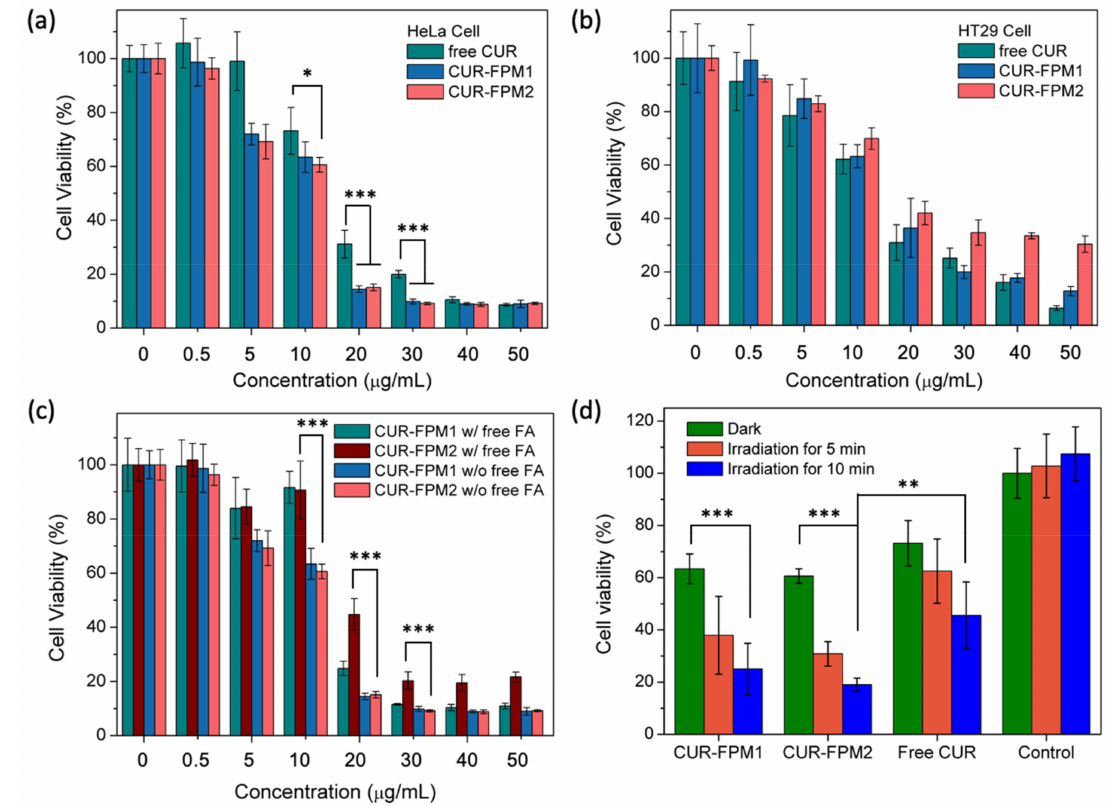
Figure 4. Cell viability of ( a ) HeLa cells and ( b ) HT-29 cells treated with free CUR, CUR-FPM1, and CUR-FPM2 micelles; ( c ) cell viability of HeLa cells treated with CUR-FPM1 and CUR-FPM2 micelles with or without the addition of 1 mM of free folic acid for competition study; ( d ) cell viability of HeLa cells treated with free CUR, CUR-FPM1, and CUR-FPM2 micelles for di ff erent irradiation times. The CUR concentration is fixed at 10 µ g / mL. Data are presented as the mean ± standard deviation. p values: * p < 0.05, ** p < 0.01, *** p < 0.001, significance